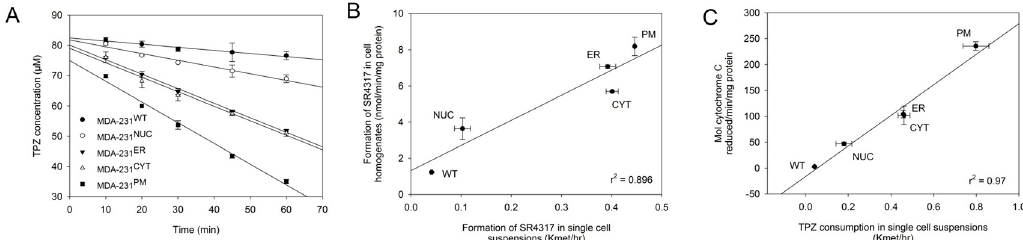
Figure 3. Expression of POR in di ff erent subcellular compartments results in increased TPZ activation: ( A ) Consumption of TPZ under anoxic conditions in parental and transfected MDA-231 cells. Results are the average of duplicate experiments, error bars indicate the range; ( B ) Correlation between the rates of anoxic formation of the non-toxic mono- N -oxide metabolite SR4317 in single cell suspensions (mean of duplicate samples) versus whole cell homogenates (mean of duplicate experiments). Error bars indicate the range in data; ( C ) Correlation between POR activity (rate of cytochrome C reduction in whole cell lysates; mean of duplicate experiments) and the rate of anoxic TPZ consumption in single cell suspensions (mean of duplicate experiments).